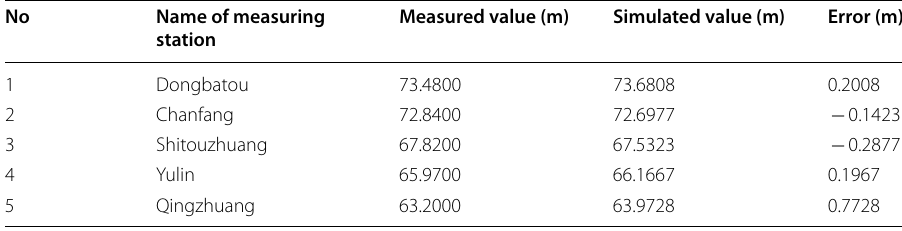
Table 1 Comparison of measured water level and simulated water level No Name of measuring station